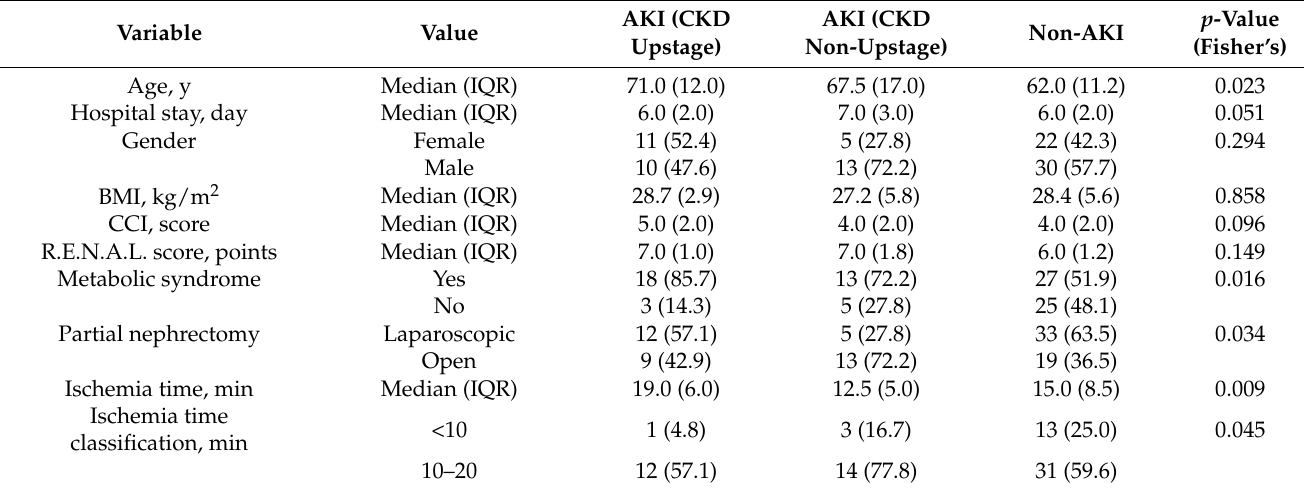
Table 1. Study patients demographic and clinical